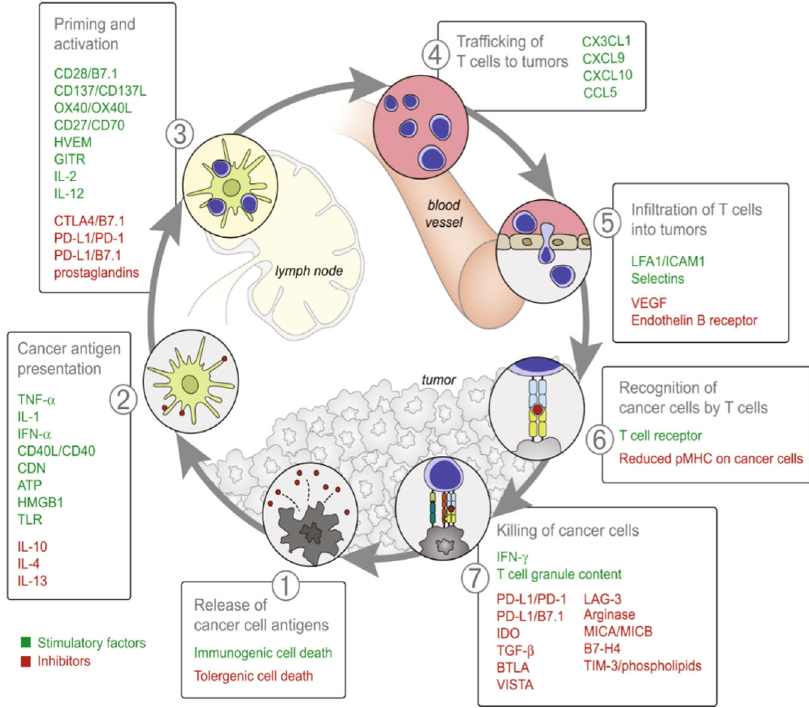
Fig. 3 Cancer immunity cycle (Reprinted from Immunity , Vol. 39 Issue 1, Daniel S. Chen, Ira Mellman, Oncology meets immunology: the cancer-immunity cycle, page 10, Copyright (2013) 32 , with permission from Elsevier (Supplementary Material)). The cycle consists of step- wise events characterising the immune response against cancer cells. Various stimulatory and inhibitory immune factors play a role in each event by activating or suppressing the anti-cancer immune response. Immune checkpoints such as CTLA-4, PD-1, PD-L1 and LAG-3 act as inhibitory factors to suppress T cell activation and prevent the killing of cancer